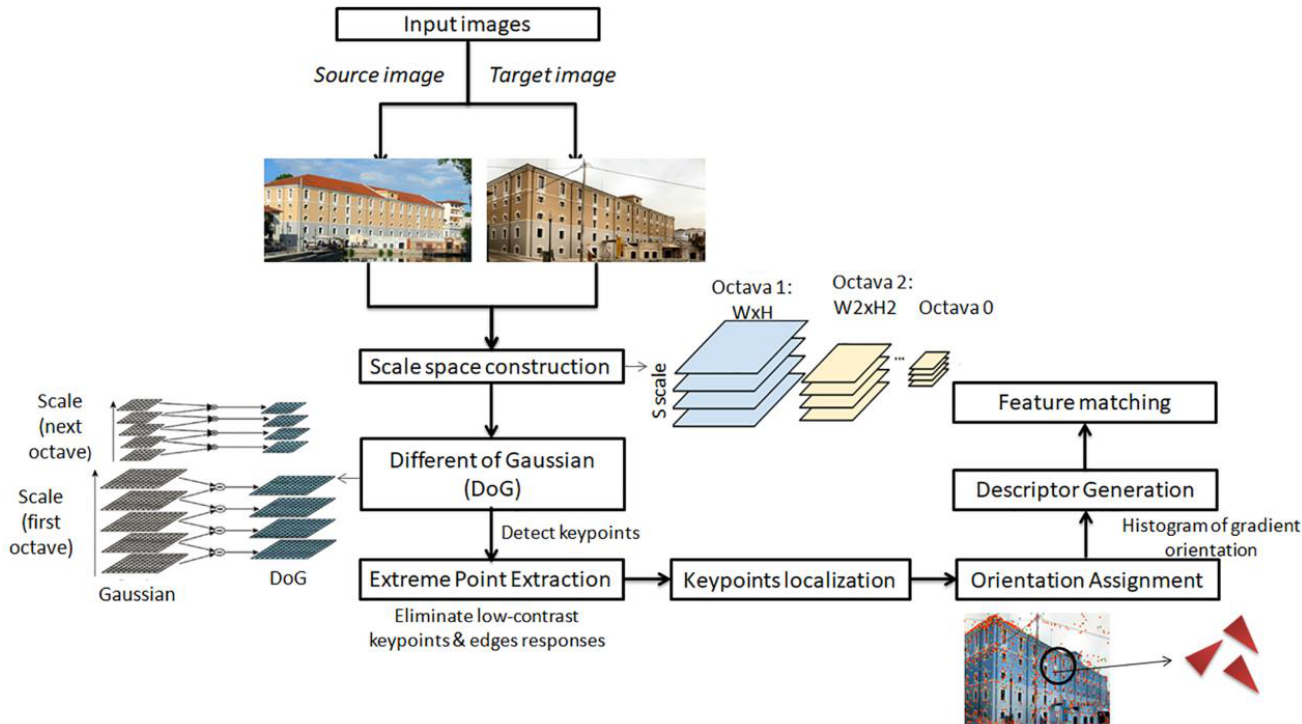
Figure 9. Workflow chart of SIFT algorithm. SIFT detector is based on the difference-of-Gaussians (DoG) operator, which is an approximation of Laplacian-of-Gaussian (LoG). Feature points are detected by searching local maxima using DoG at various scales of the subject images. The description method extracts a 16 × 16 neighborhood around each detected feature and further segments the region into sub-blocks, rendering a total of 128 bin values.